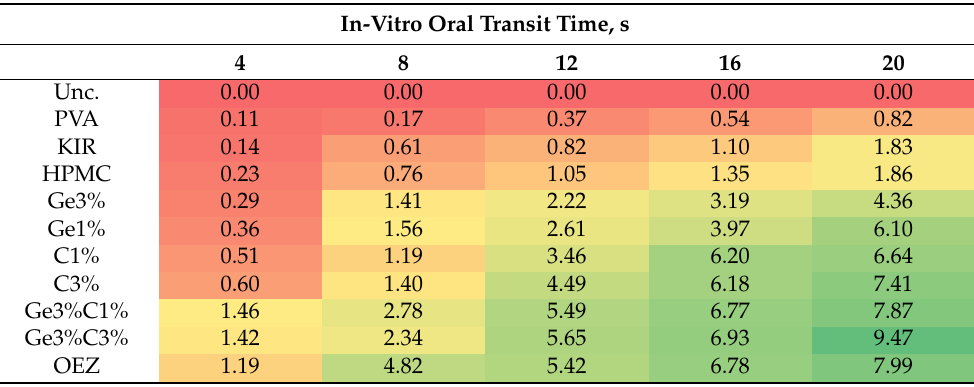
Table 4. Swallowability matrix of coated tablet formulations of sequential presentational performance, as determined by the swallowability index ranked from poor (red), pass (orange), good (yellow), very good (lime green), to excellent (dark green).